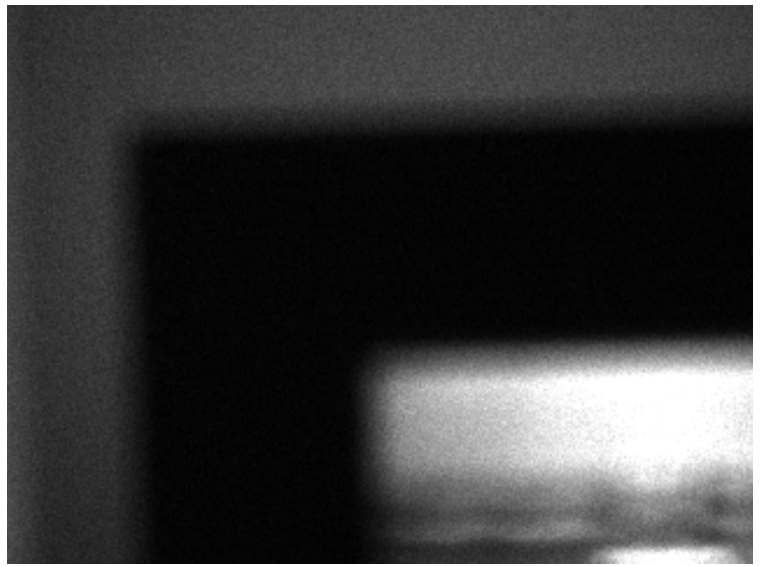
Figure 9. Sample image frame from the recorded sequence (resolution 320 × 240 with intentional lack of